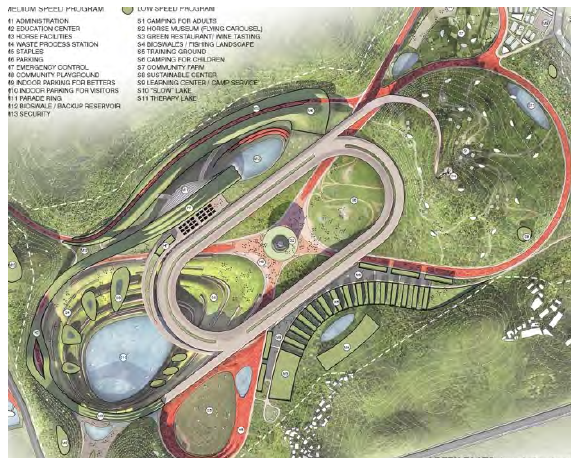
Figure 7. The master plan of Horsetopia Park (Source: (Architects, 2019).